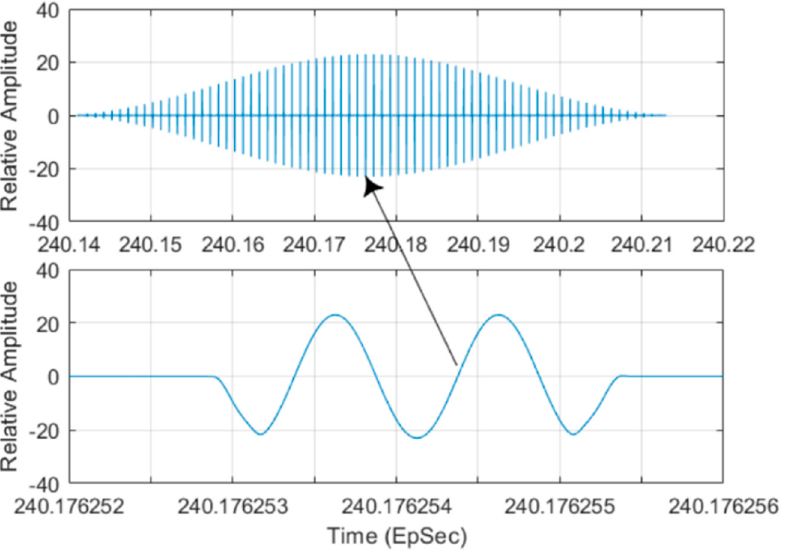
Figure 16. Signal in the main lobe shown in the bottom plot in Figure 15 ( top ), the detailed waveform in the middle line of the top plot ( bottom ). in the middle line of the top plot ( bottom